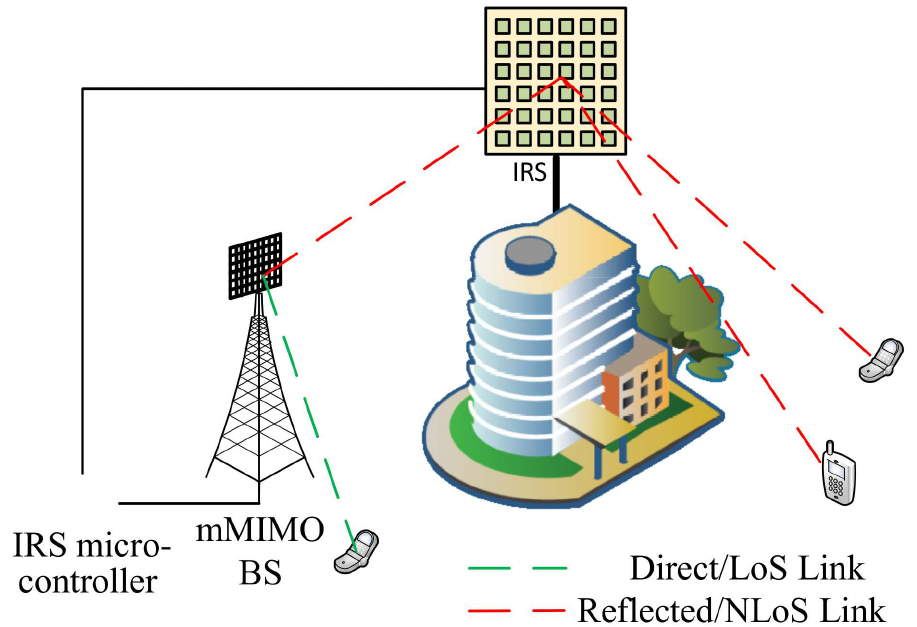
Figure 1. Illustration of a Reconfigurable Intelligent Surface (RIS)-assisted communication